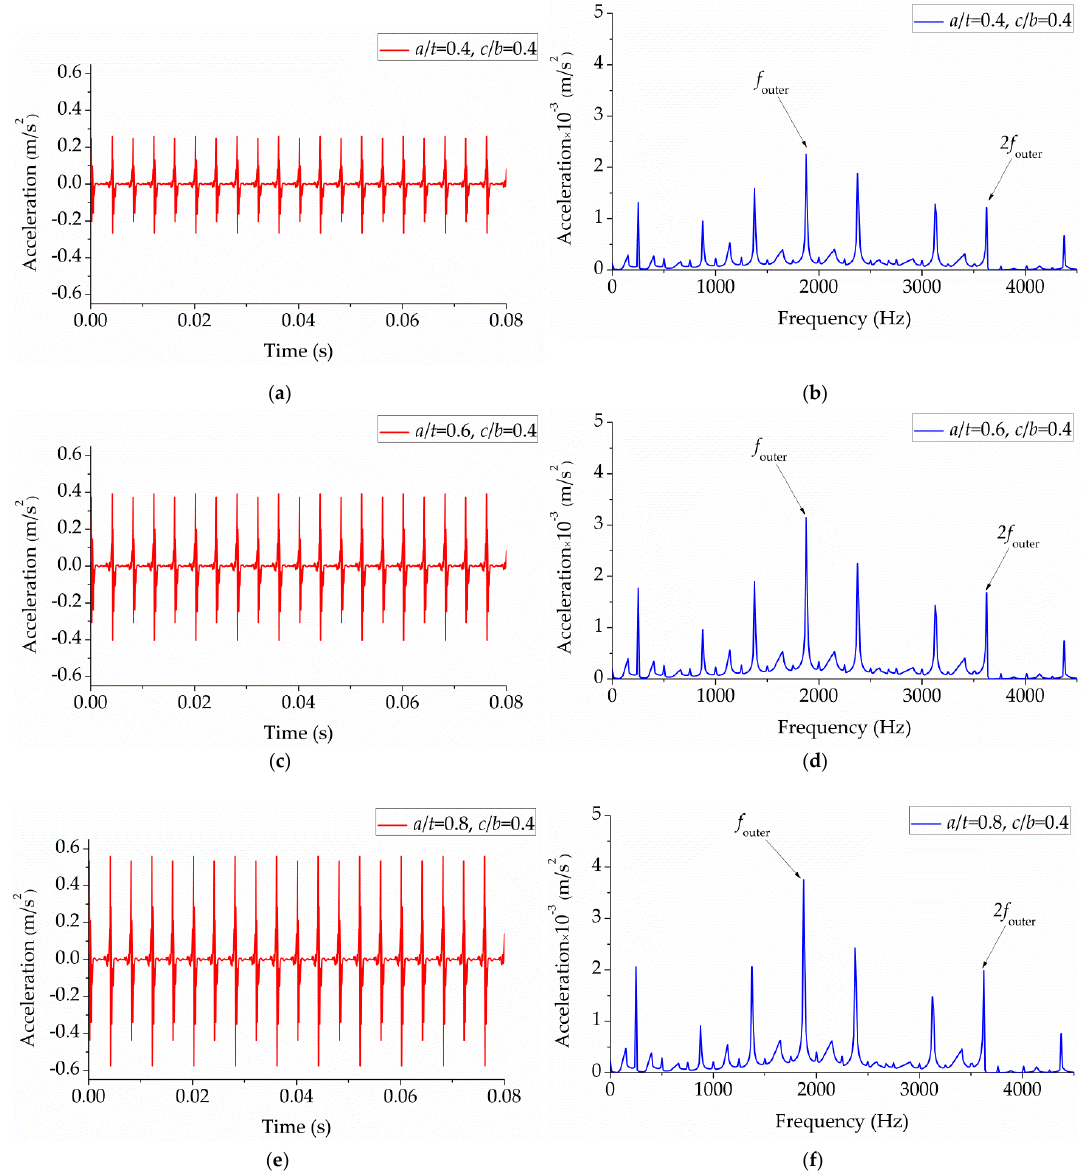
Figure 11. c / b = 0.4 time domain and frequency domain curves of vibration signals corresponding to different a / t : ( a , b ) Time-domain and frequency-domain response signals in case a / t = 0.4 c / b = 0.4; ( c , d ) time-domain and frequency-domain response signals in case a / t = 0.6 c / b = 0.4; ( e , f ) time-domain and frequency-domain response signals in case a / t = 0.8 c / b = 0.4.